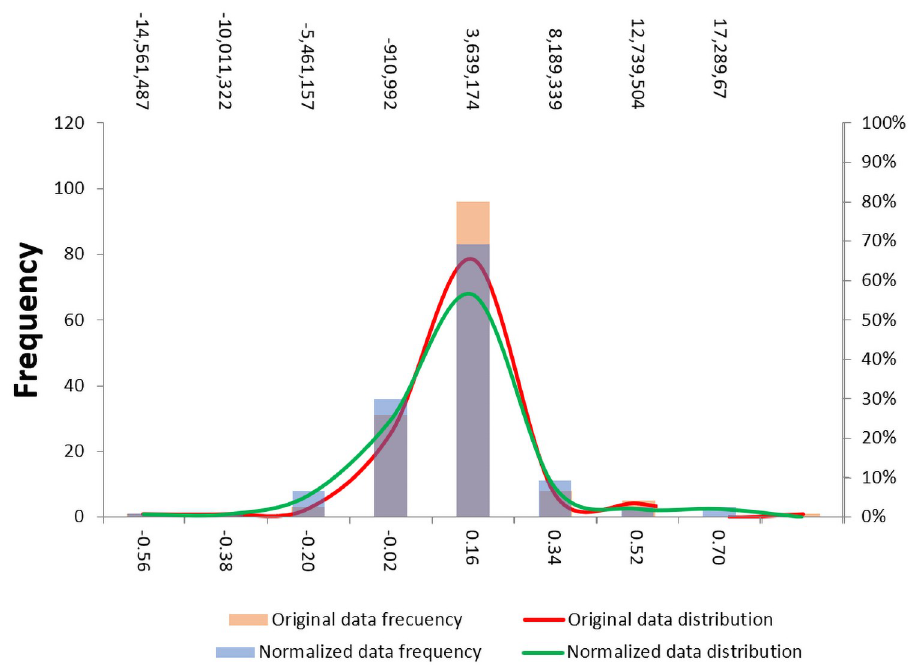
Fig 14. Distribution of the specific competitiveness indexes before and after the normalization.